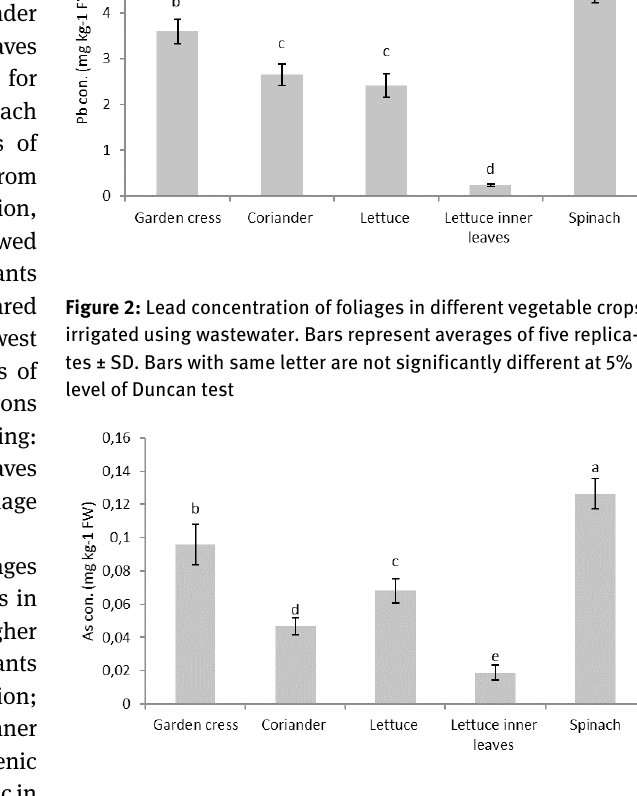
Figure 3: Arsenic concentration of foliages of different vegetable crops irrigated using wastewater. Bars represent averages of five replicates ±SD. Bars with same letter are not significantly different at 5% level of Duncan